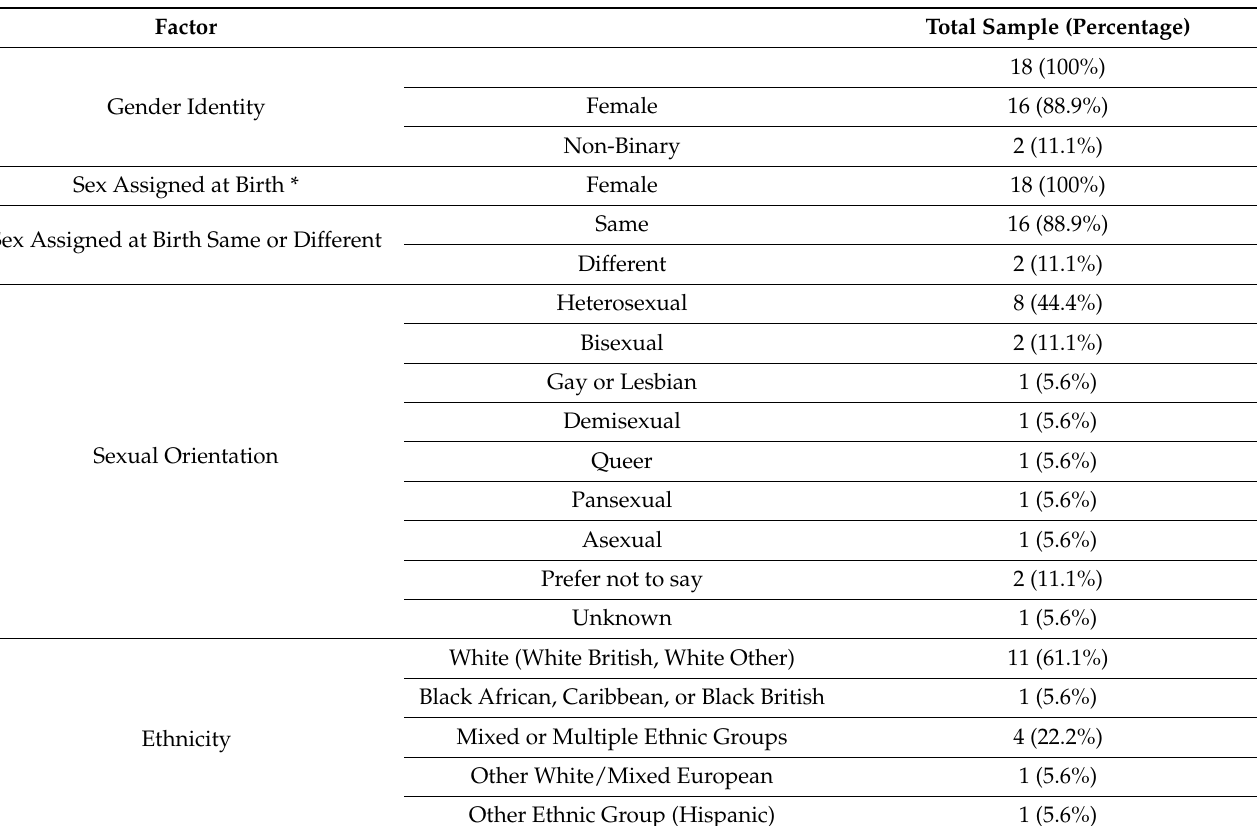
Table 1. Young Person Demographics.